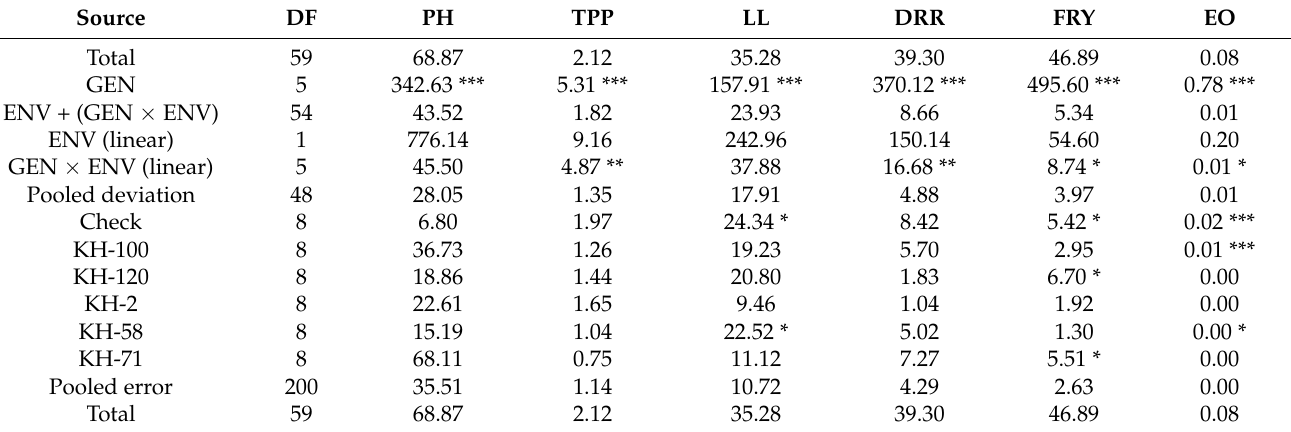
Table 2. ANOVA based on joint regression for the agronomical traits of six high-yielding genotypes of C. caesia in